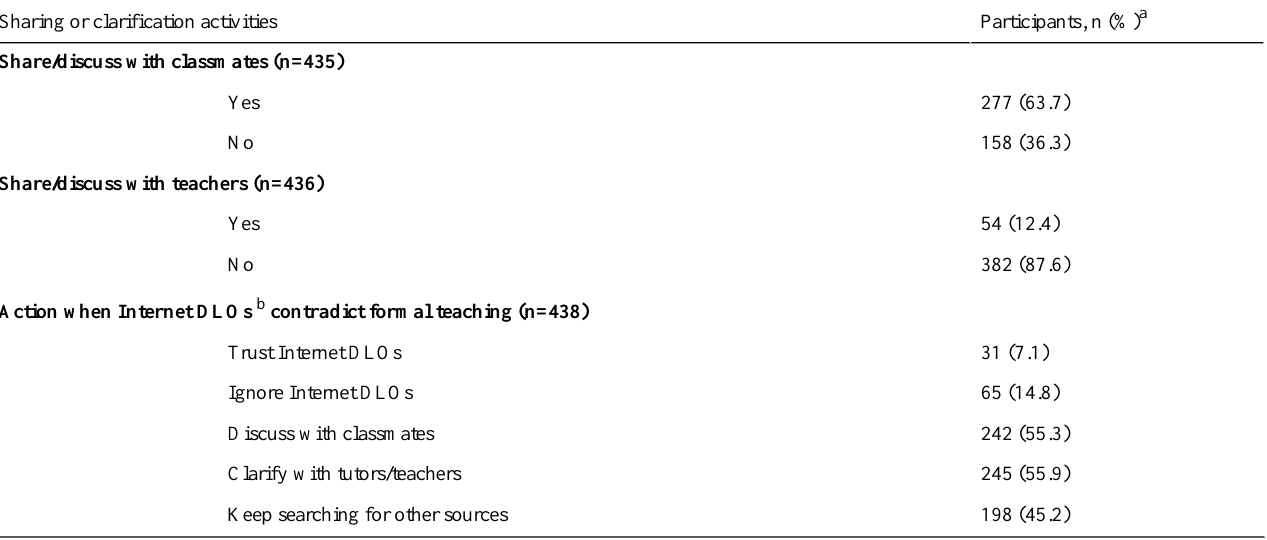
Table 4. Sharing and clarification of Internet digital learning